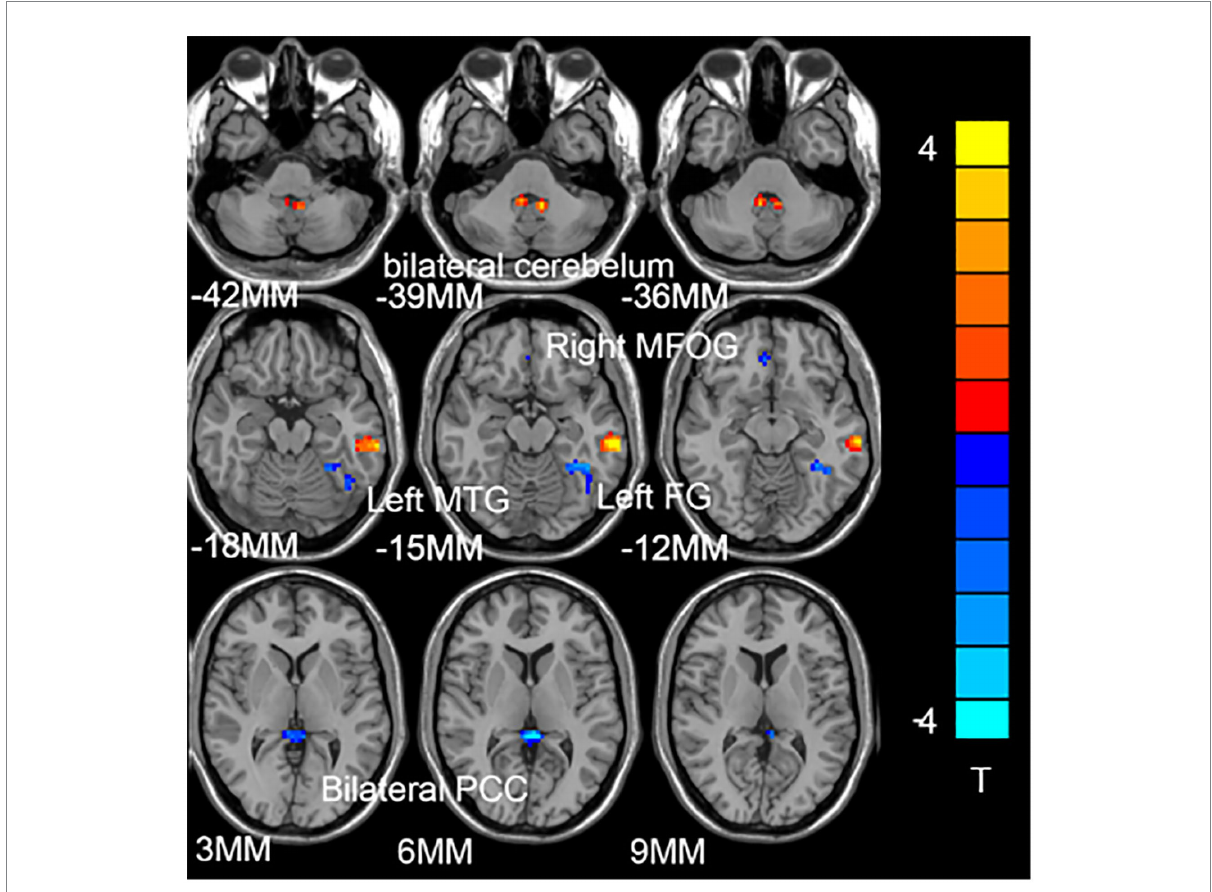
FIGURE 1 Compared with the healthy control subjects (HCs), the brain regions of patients with generalized anxiety disorder (GAD) have abnormal degree centrality (DC) values. The blue represents the decrease in DC value, and the red represents the increase in DC